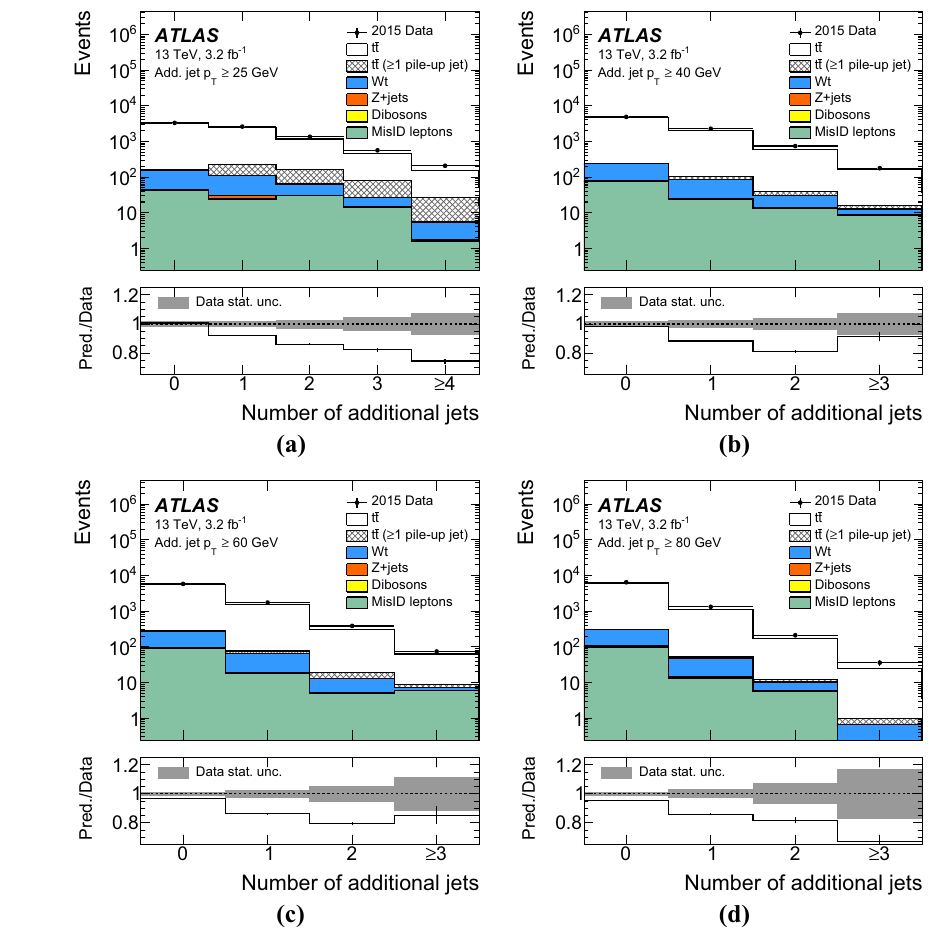
Fig. 1 Multiplicity of additional jets with a p T > 25 GeV, b p T > 40 GeV, c p T > 60 GeV, and d p T > 80 GeV for selected events at reconstruction level in data and simulation. Simulated signal events with at least one additional jet identified as pile-up are indicated in grey . The contribution of pile-up jets to the backgrounds is negligible. The lower panel shows the ratio of the total prediction to the data ( solid line ), the grey band represents the statistical uncertainty of the measurement, and the error bars on the solid line show the statistical uncertainty in the signal MC